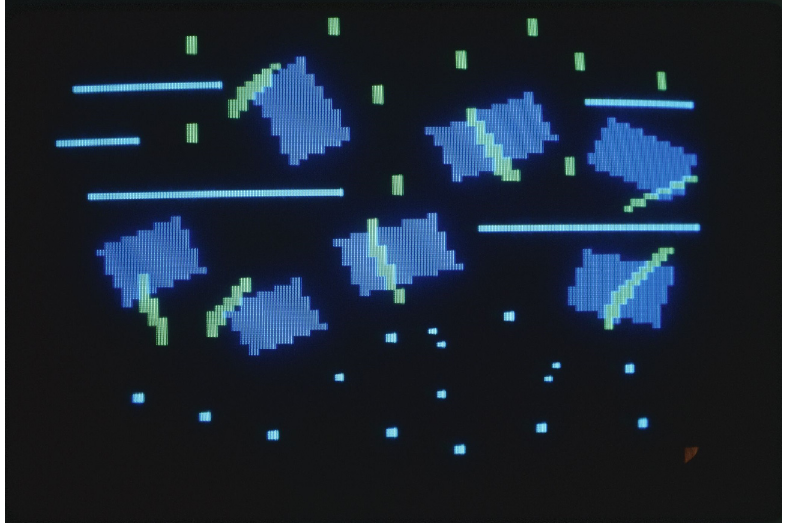
Figure 9. Image from “Une musique pour un petit é cran ?”, project by the composer Frank Royon Le M é e for Art Acc è s . Collection Les Immat é riaux © Kandinsky Library, MNAM/CCI, Centre